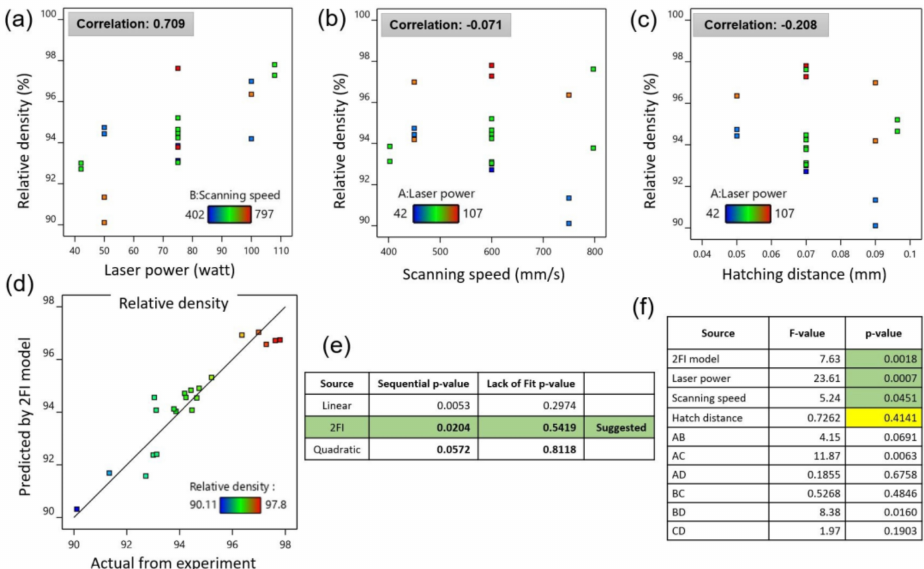
Figure 5. Optimization of micro-LPBF process parameters using response surface method for pro- cessing of Inc718; correlation between relative density and ( a ) laser power, ( b ) scanning speed and ( c ) hatch distance; ( d – f ) fitting a model corresponding to central composite design.